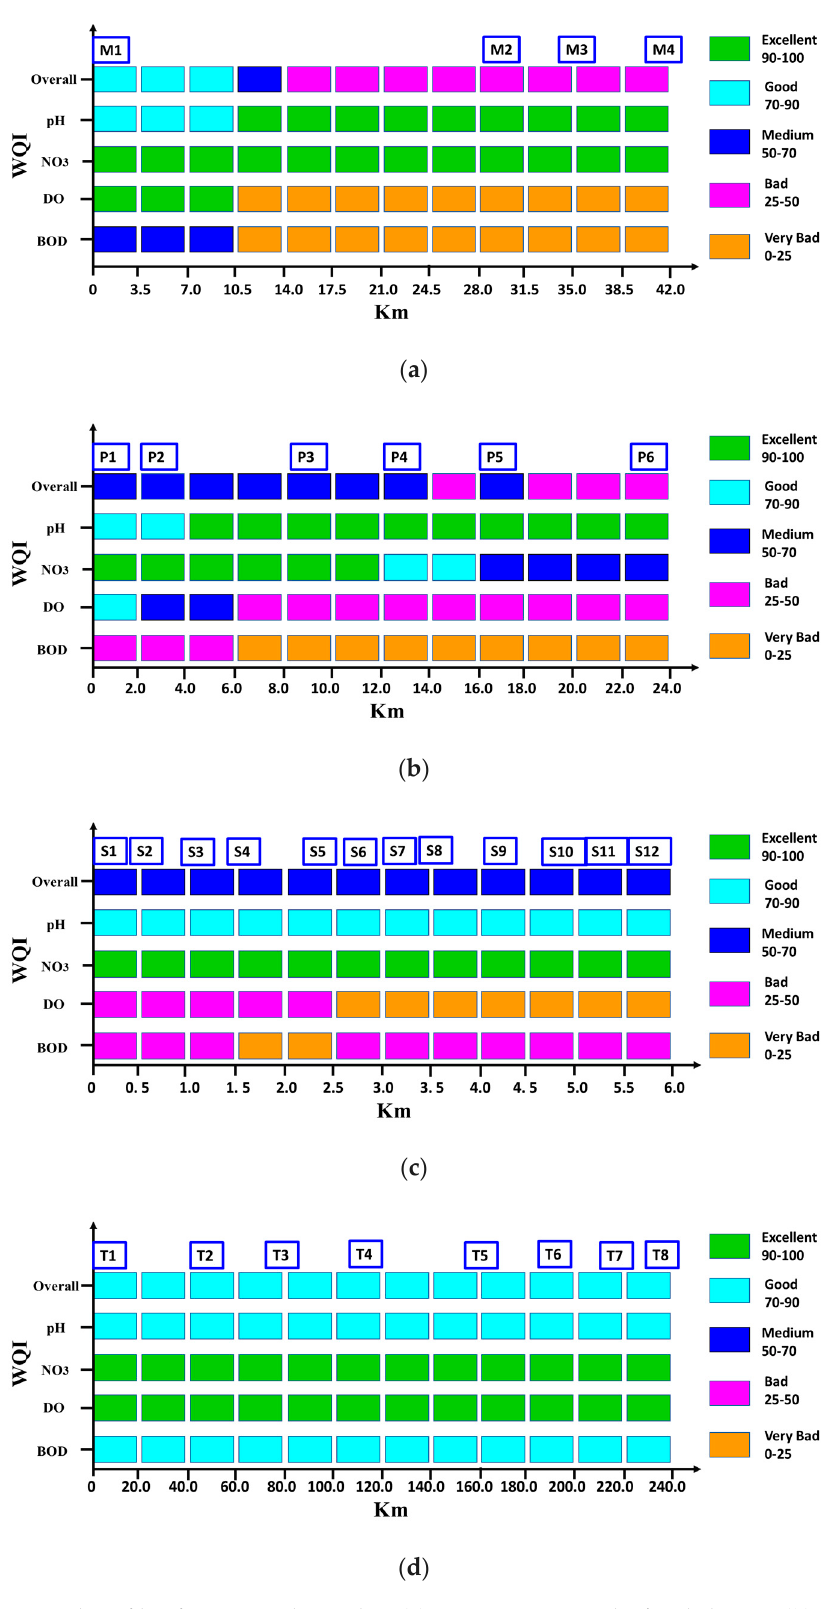
Figure 9. Spatial profile of water quality index: ( a ) Yamuna River India/arid climate, ( b ) Baghmati River Nepal/temperate climate, ( c ) Galing River Malaysia/tropical climate, and ( d ) Nakdong River Korea/cold climate.